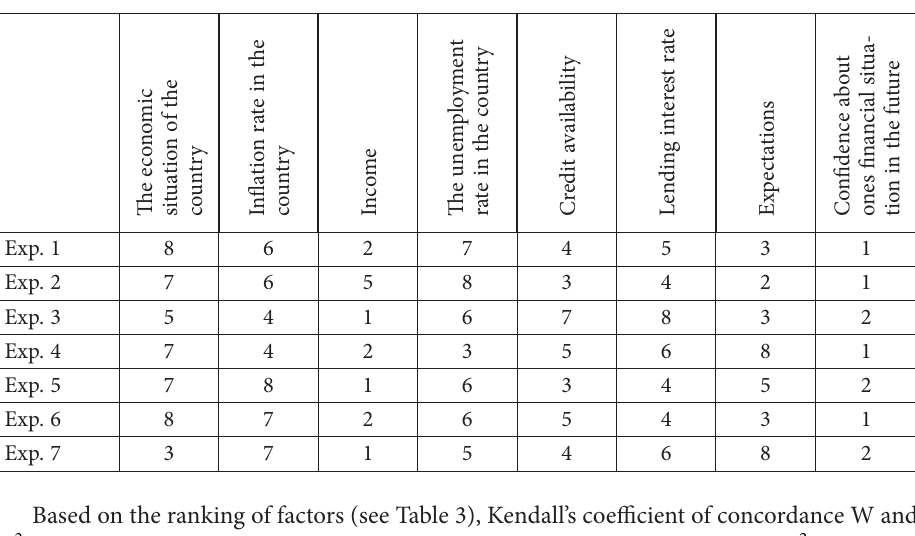
Table 3. Ranking of factors influencing people financial decisions (source: authors’ calculations)